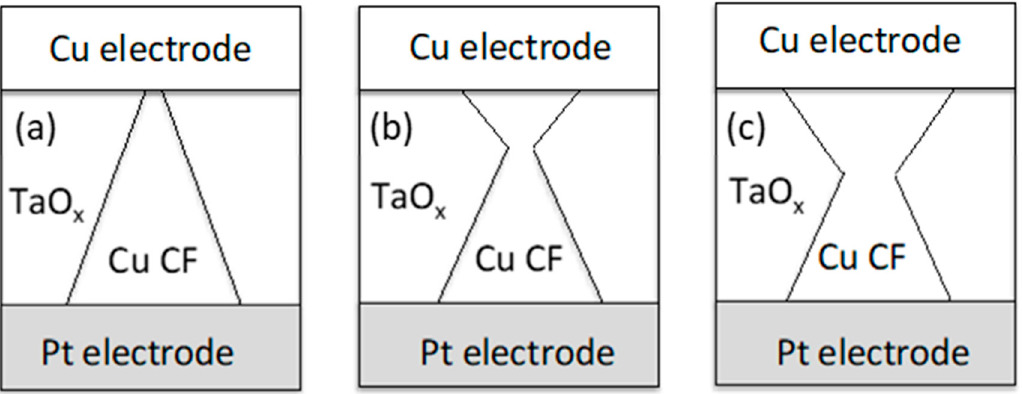
Figure 4. Di ff erent geometrical shapes approximating the hypothesized form of a Cu filament: Figure 4. Different geometrical shapes approximating the hypothesized form of a Cu filament: (a) (a) conventionally assumed shape of a truncated cone; (b) an hourglass-shaped filament formed at low conventionally assumed shape of a truncated cone; (b) an hourglass ‐ shaped filament formed at low I cc ; (c) an hourglass-shaped filament formed at high I cc I cc ; (c) an hourglass ‐ shaped filament formed at high I cc . Table 1. Degradation D of the neighbor cells of the heated device.